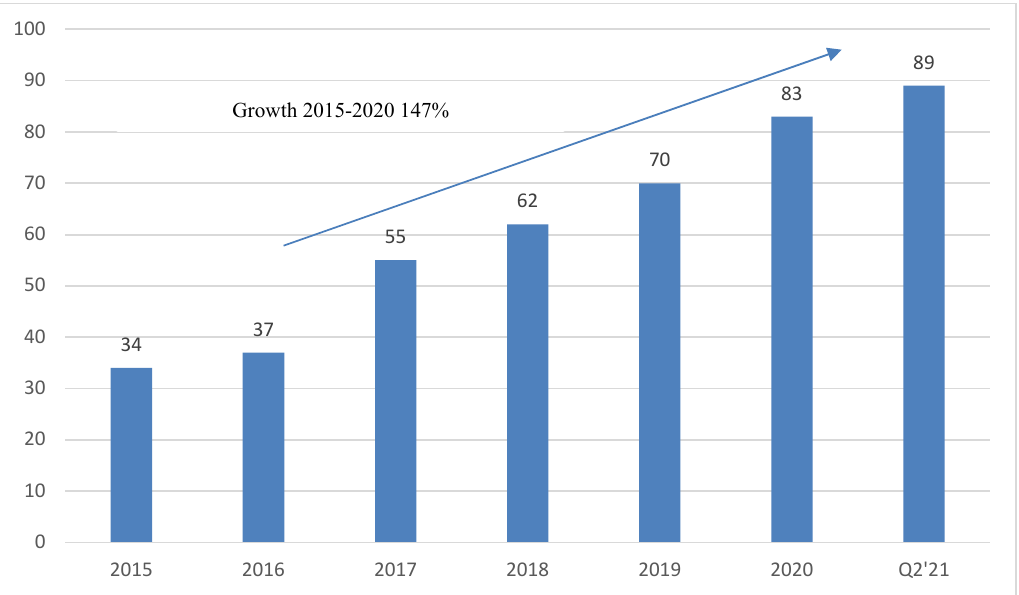
Fig.1. Growth in the number of customers in the East Java region, in